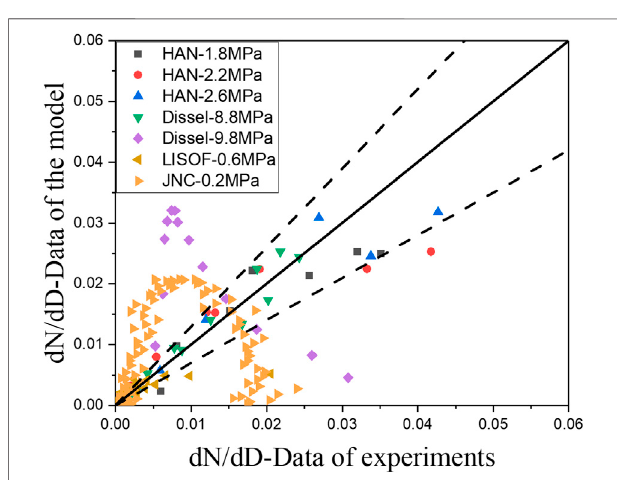
FIGURE 9 | Relative error of droplet size number obtained by the model constrained with mass equation.